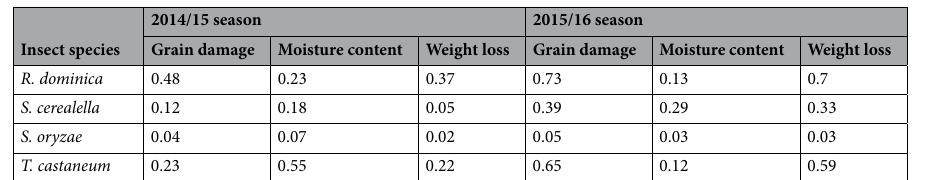
Table 8. Correlations between the total populations (live and dead) of each storage insect pest species present and sorghum grain damage, weight loss and grain moisture content during the 2014/15 and 2015/16 storage seasons (n = 280).